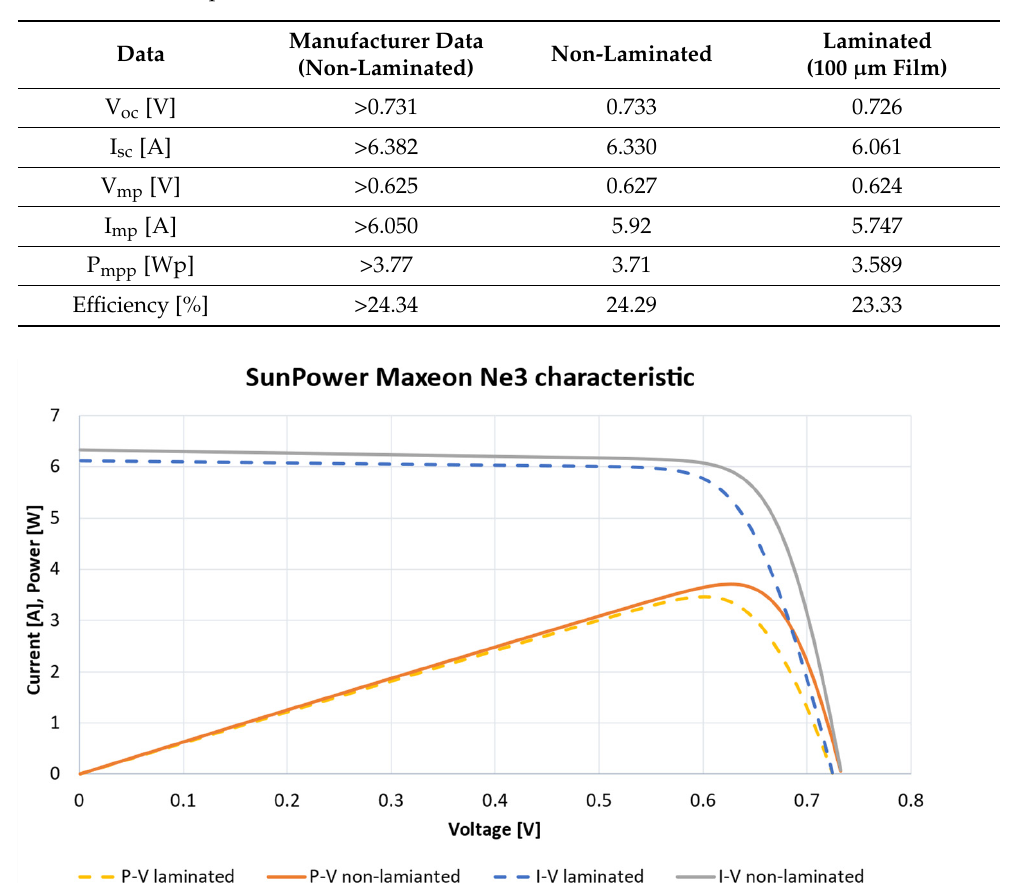
Figure 16. I-V and P-V characteristics of the SunPower Maxeon Ne3.